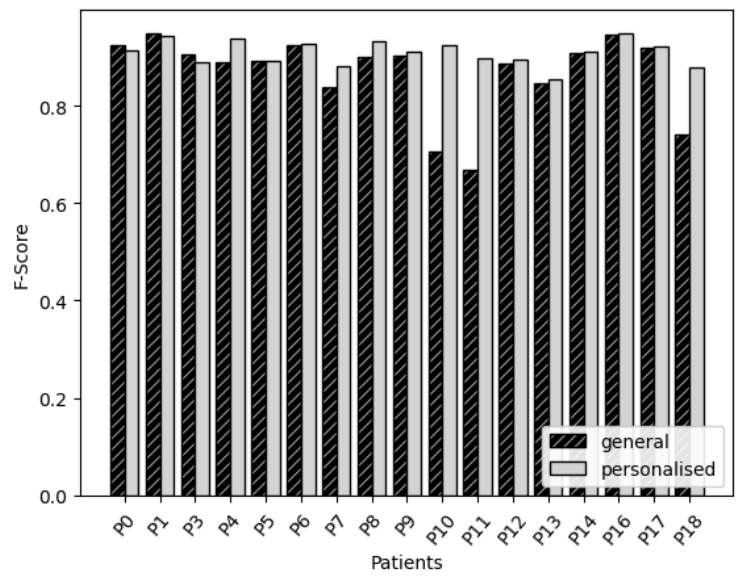
Figure 2. Neural networks: comparison of the accuracy of general and personalised models for each